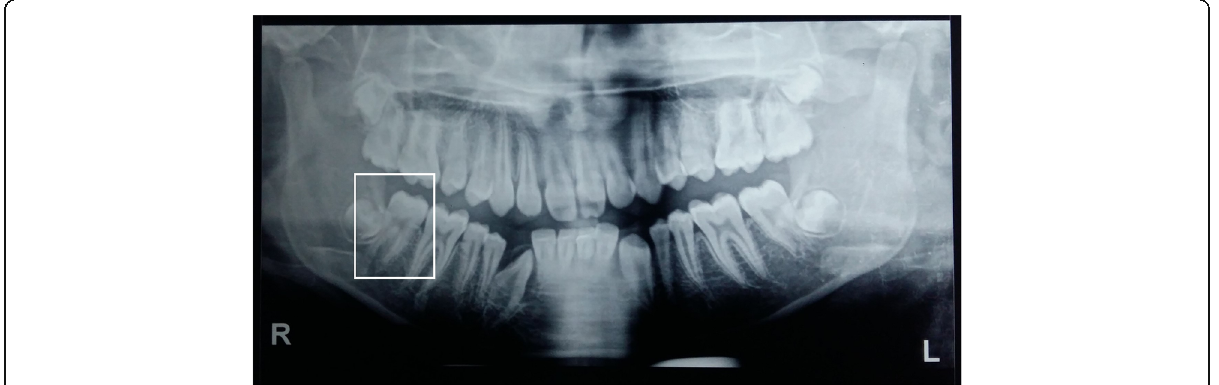
Fig. 1 Orthopentomograph of a subject showing calcification stage of right mandibular second molar